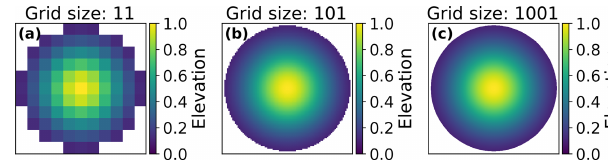
Figure 2. Gaussian hill elevations at n = 11, 101, and 1001. As grid sizes increase, a smoother surface is generated. Note that the hori- zontal and vertical units are arbitrary and that the grid cell spacings are an expression of the width-to-height ratio of the surface. Cross sections of the shapes at all grid sizes can be seen in Fig.